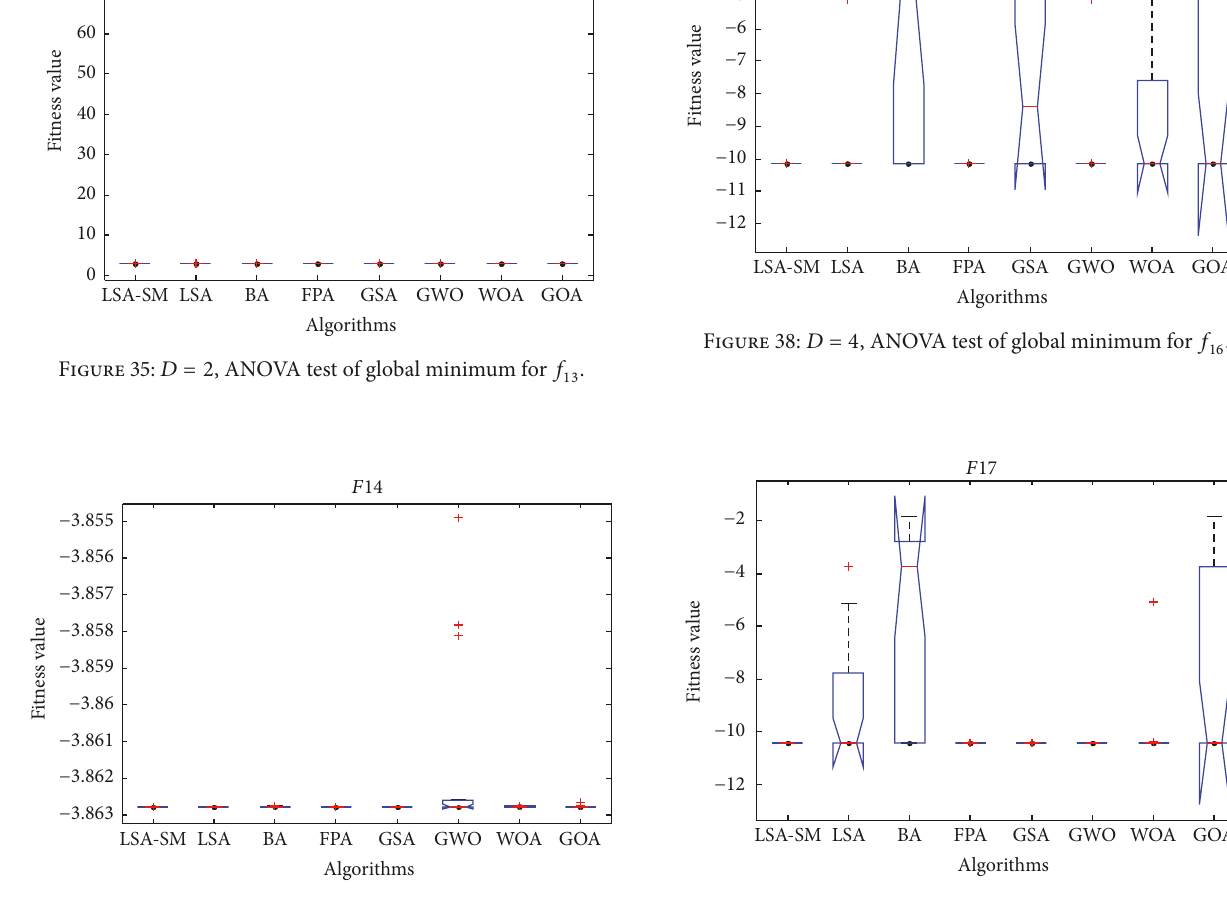
Figure 36: 𝐷 = 3 , ANOVA test of global minimum for 𝑓 14 .